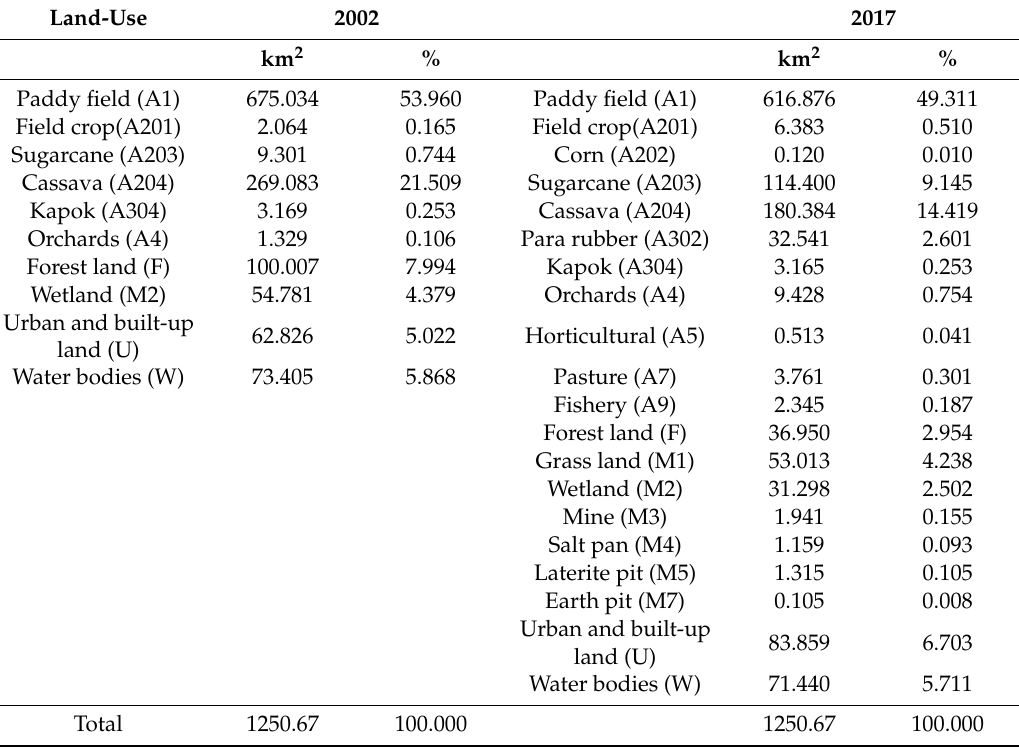
Table 6. Comparison of land-use in the KLsarea during 2002–2017.